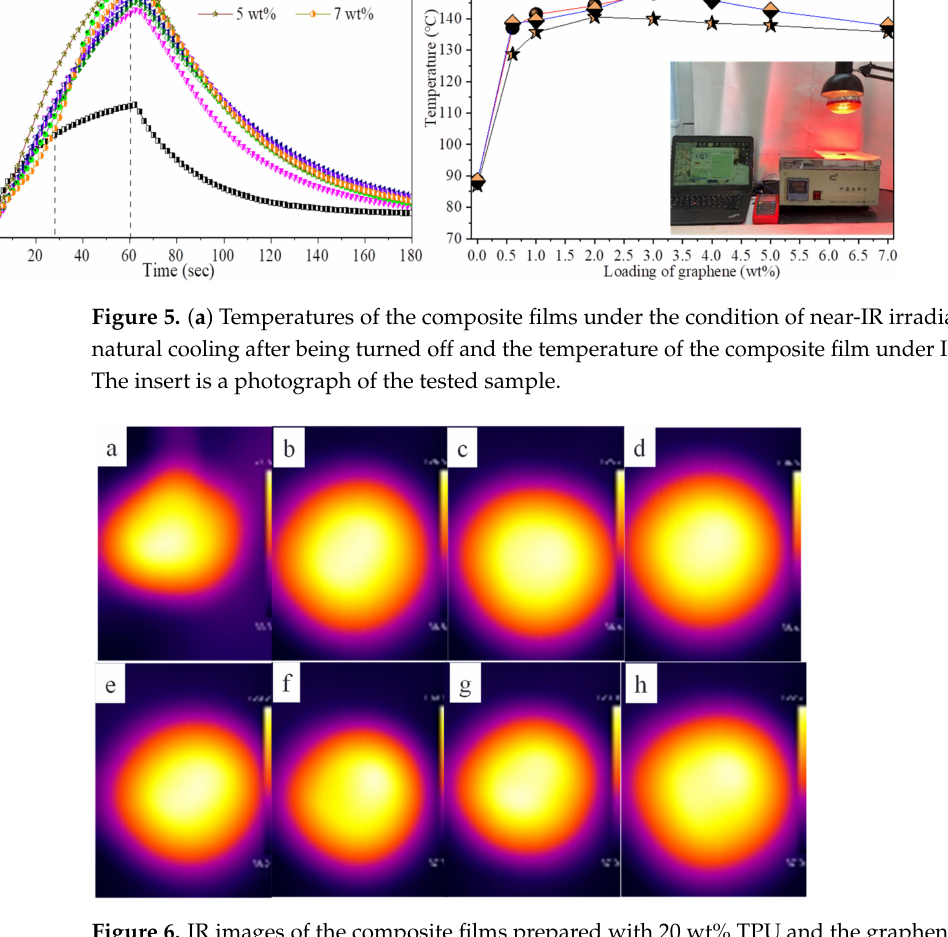
Figure 6. IR images of the composite films prepared with 20 wt% TPU and the graphene loadings of 0 ( a ), 0.6 wt% ( b ), 1 wt% ( c ), 2 wt% ( d ), 3 wt% ( e ), 4 wt% ( f ), 5 wt% ( g ) and 7 wt% ( h ), respectively, under near-IR irradiation for 60